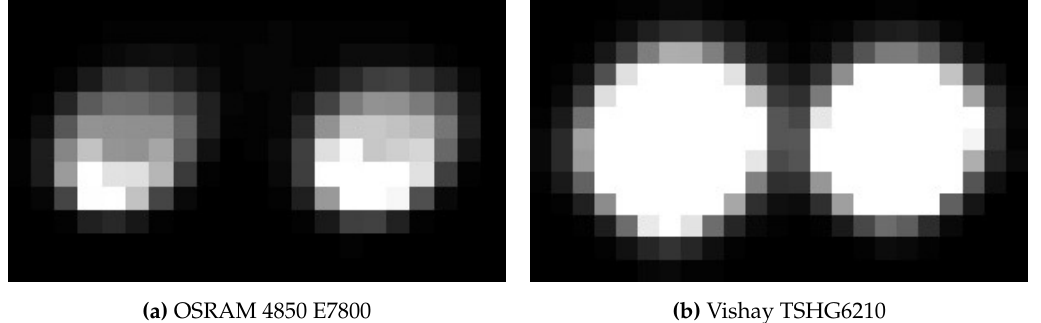
Figure 14. Comparison of blob quality at 110 m with an inter LED distance of 34